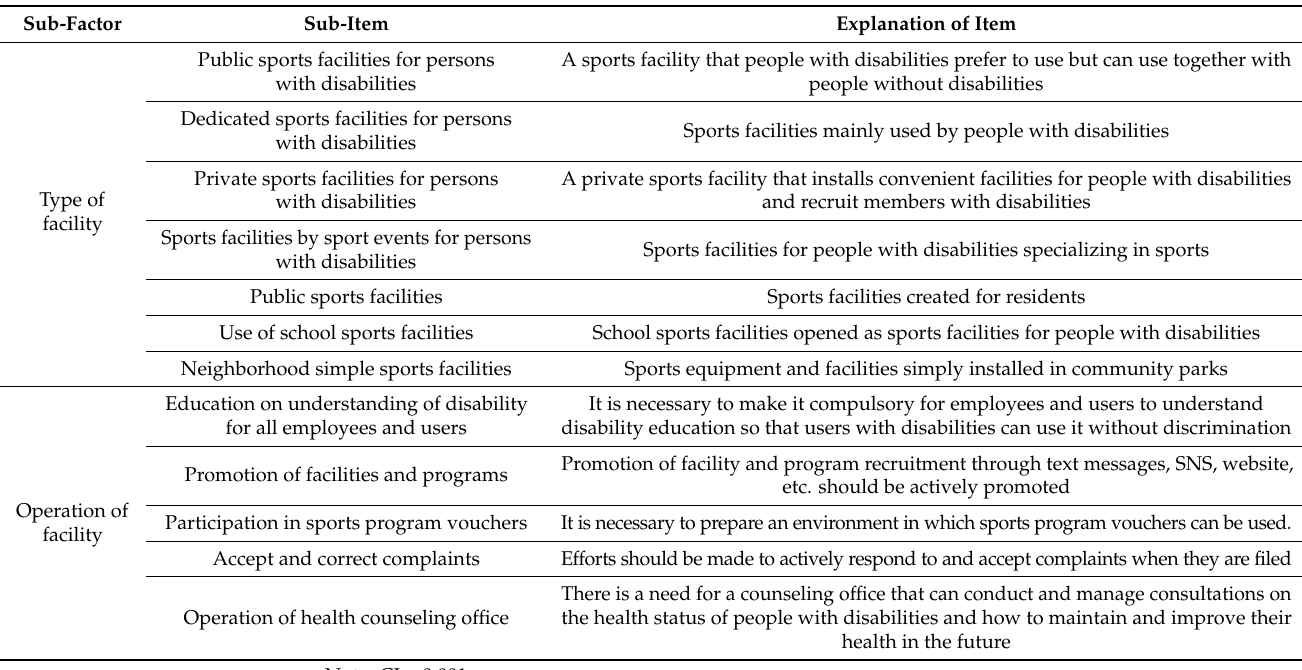
Table 12. Explanation of H4 by the facility in